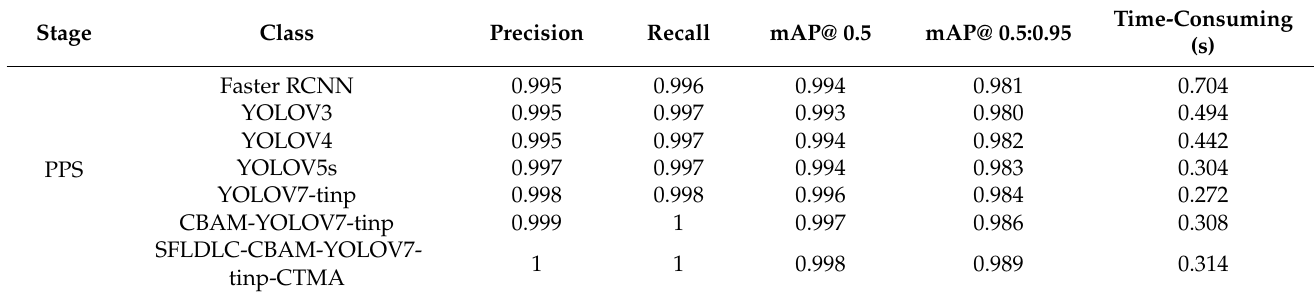
Table 6. Comparison of different recognition methods in